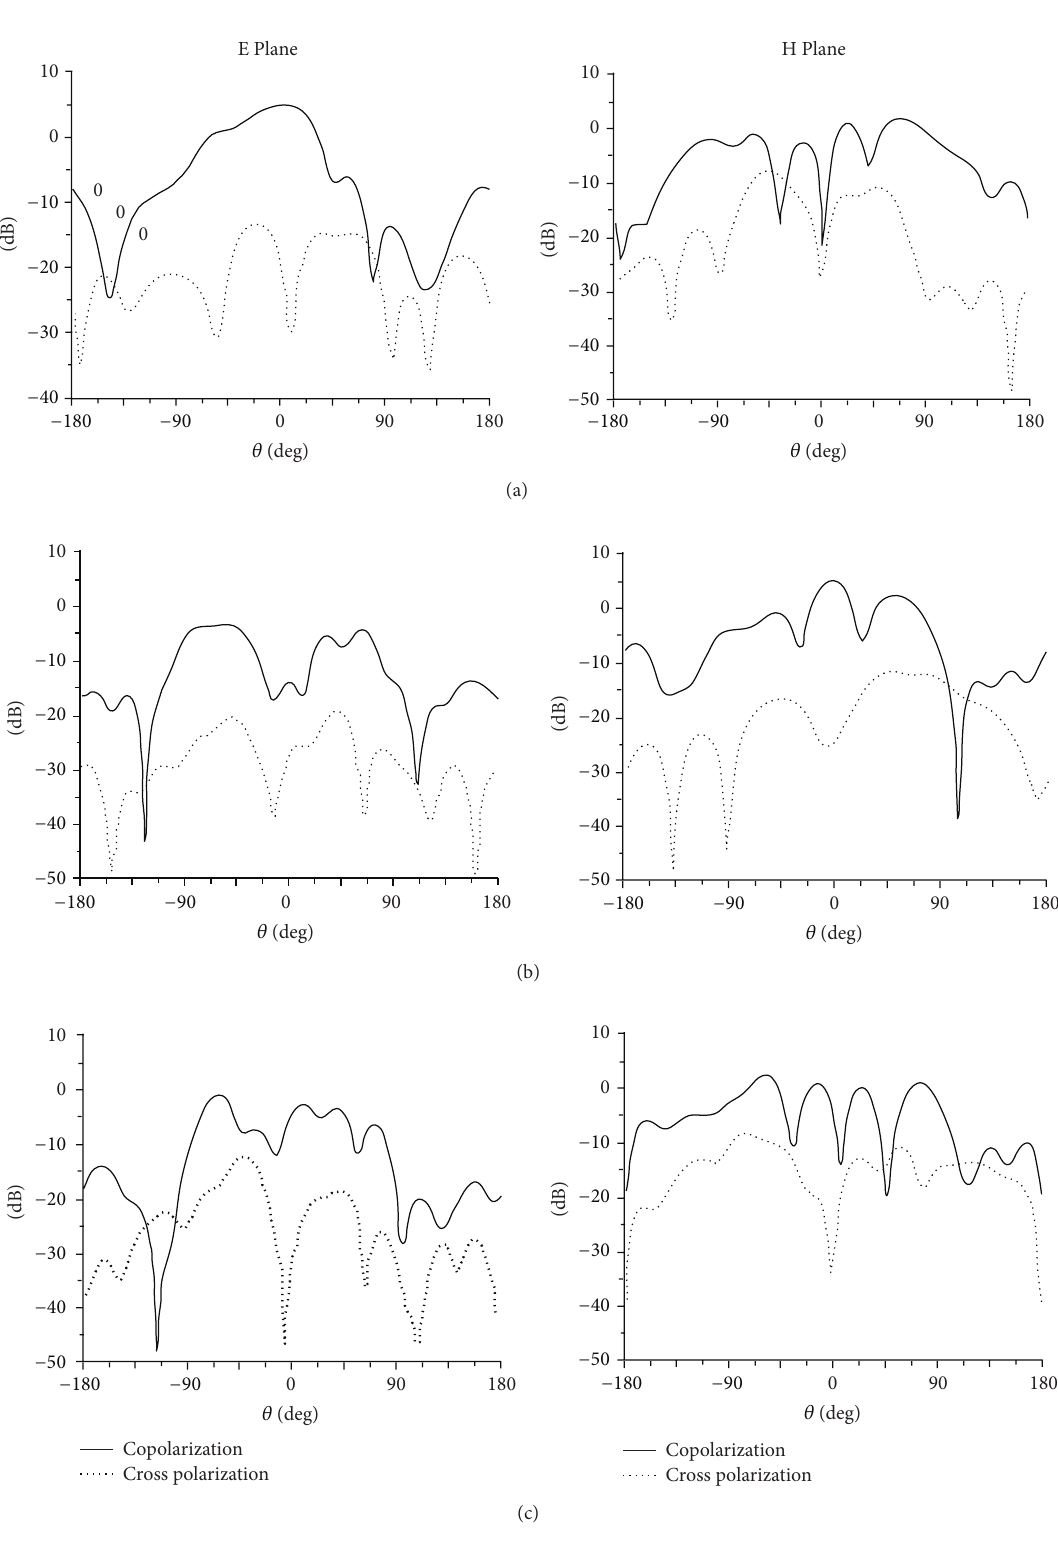
Figure 7: Measured radiation pattern of the proposed antenna at (a) 15.15GHz, (b) 18.2 GHz, and (c) 19.5